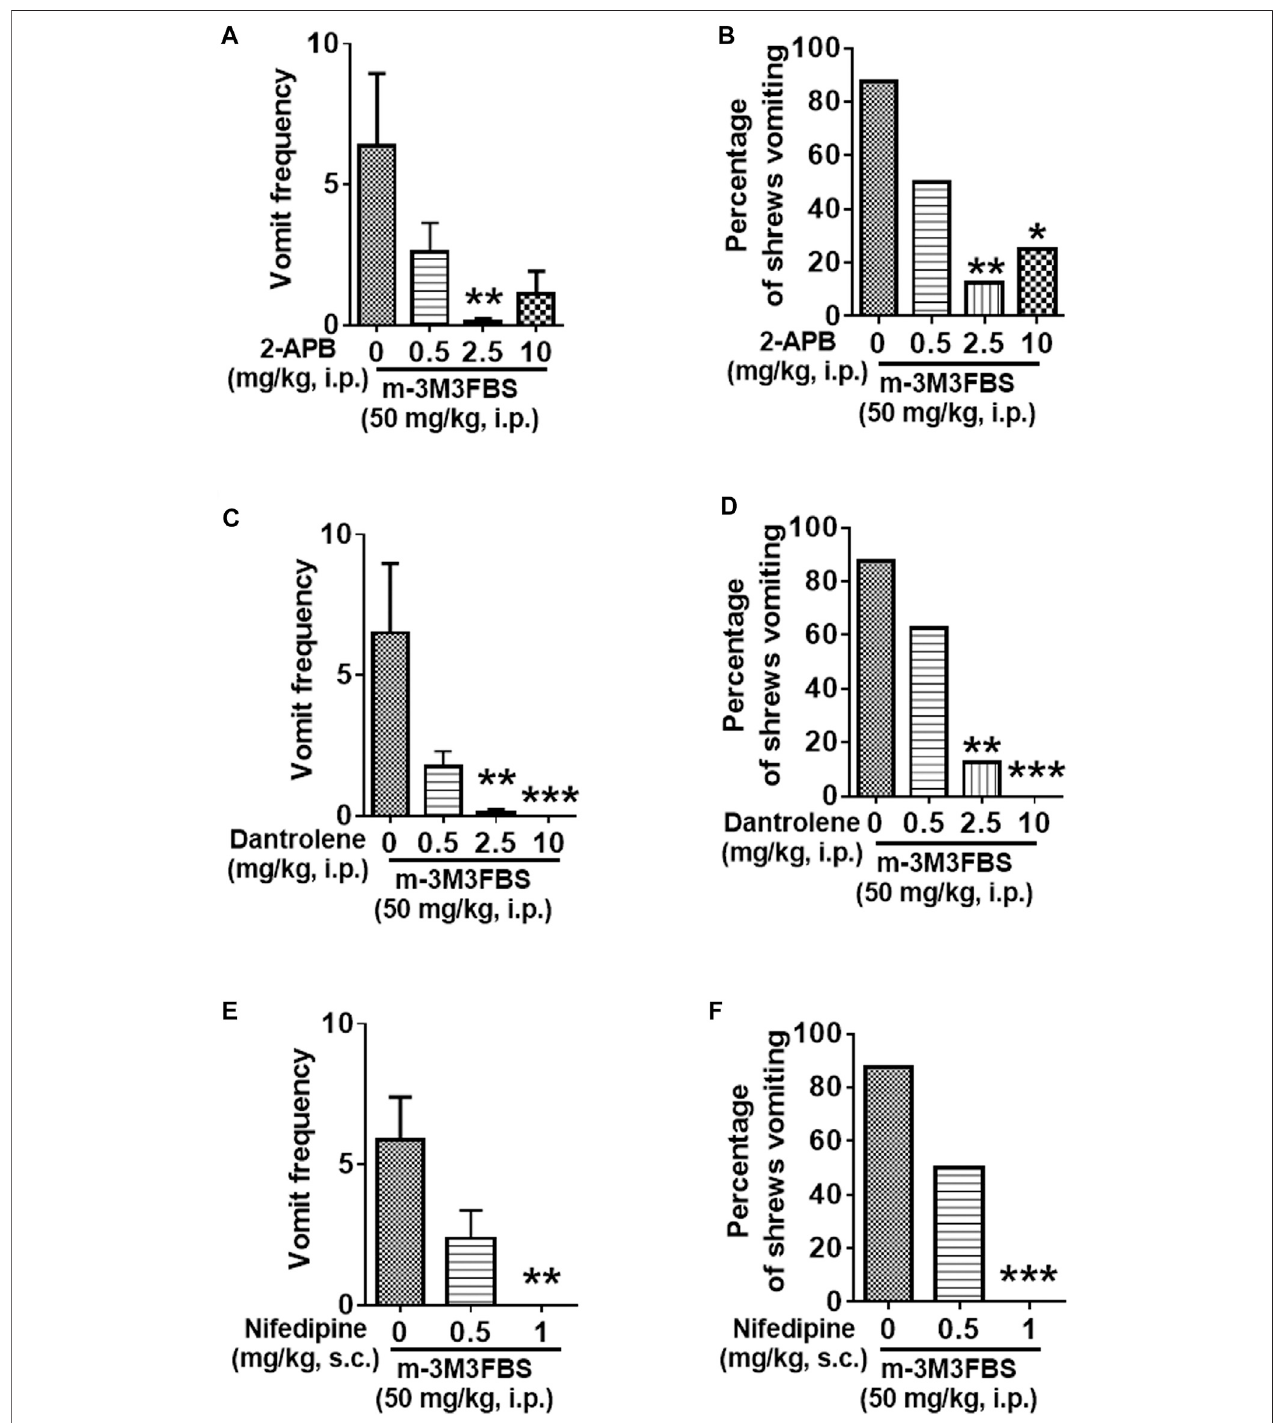
FIGURE6| TheantiemeticeffectsofCa 2+ channelsmodulators againstm-3M3FBS-inducedemesis. Thirty minutespriortoaninjection ofm-3M3FBS (50 mg/kg, i.p.),differentgroupsofleastshrewsweregivenaninjection(i.p.)ofeitherthecorrespondingvehicle,orvaryingdosesof:1)theIP 3 Rantagonist2-APB( n (cid:1) 8) (A,B) ,2)the RyR antagonist dantrolene ( n (cid:1) 8 shrews per group) (C,D) , or 3) the LTCC inhibitor nifedipine (s.c.) ( n (cid:1) 8 shews per group) (E,F) . Emetic parameters were recorded for the next 2 h min post m-3M3FBS injection. (A,C,E) The frequency of emesis was analyzed with Kruskal-Wallis non-parametric one-way ANOVA followed by Dunnett ’ s post hoc test and presented as mean ± SEM. (B,D,F) The percentage of shrews vomiting was analyzed with chi-square test and presented as mean. * p < 0.05, ** p < 0.01, **** p < 0.0001 vs. 0 mg/kg.